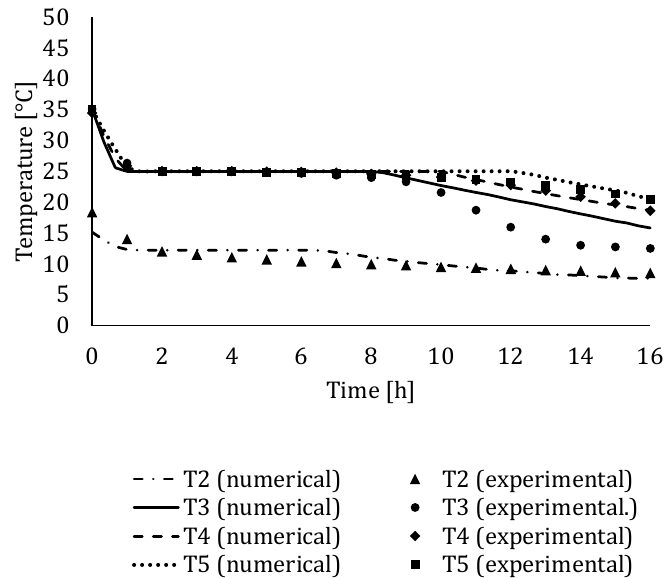
Figure 11. Comparison of transient temperature variations of the HTF and PCM during solidification obtained numerically and experimentally for HTF flow rate 620 l/h and HTF inlet temperature 7 °C.